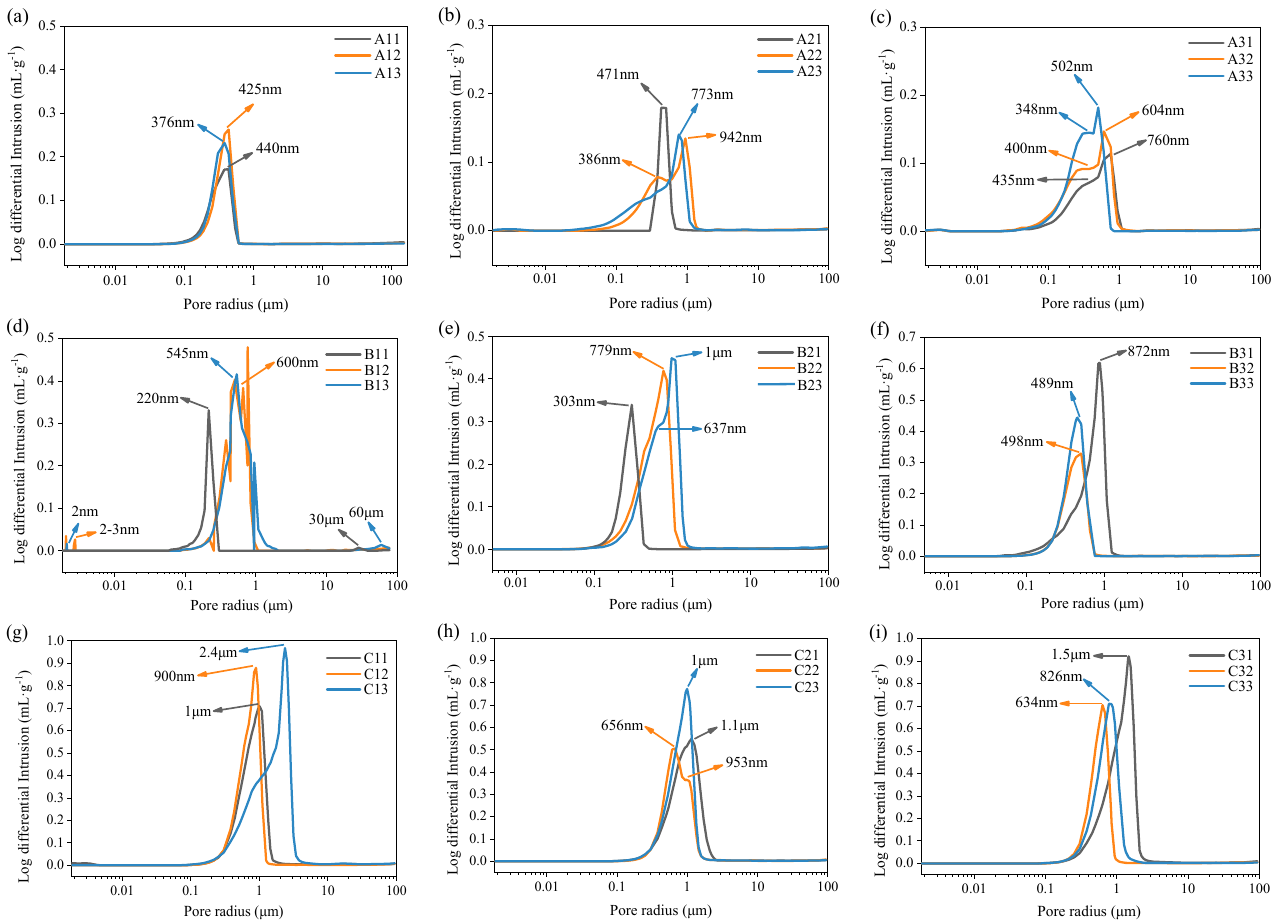
Figure 1. Pore size distribution in porous alumina samples with different contents of pore-forming agents. ( a ) 30 vol.% pore formers (CF:Graphite = 3:7) + 70 vol.% alumina; ( b ) 30 vol.% pore formers (CF:Graphite = 5:5) + 70 vol.% alumina; ( c ) 30 vol.% pore formers (CF:Graphite = 7:3) + 70 vol.% alumina; ( d ) 50 vol.% pore formers (CF:Graphite = 3:7) + 50 vol.% alumina; ( e ) 50 vol.% pore formers